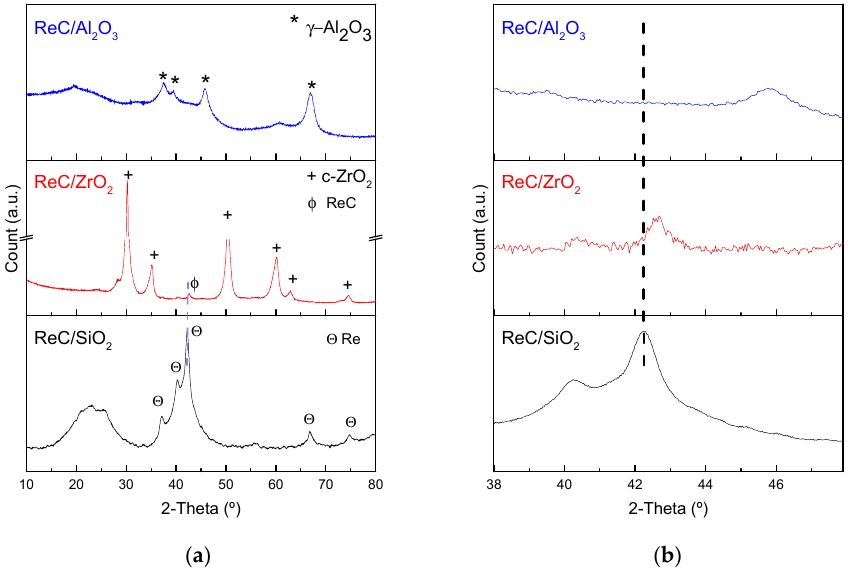
Figure 2. Diffractograms obtained for the catalysts ( a ), zoom in the region from 38° to 48° ( b )